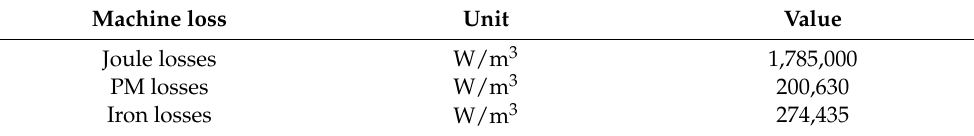
Table 7. Internal heat sources of the